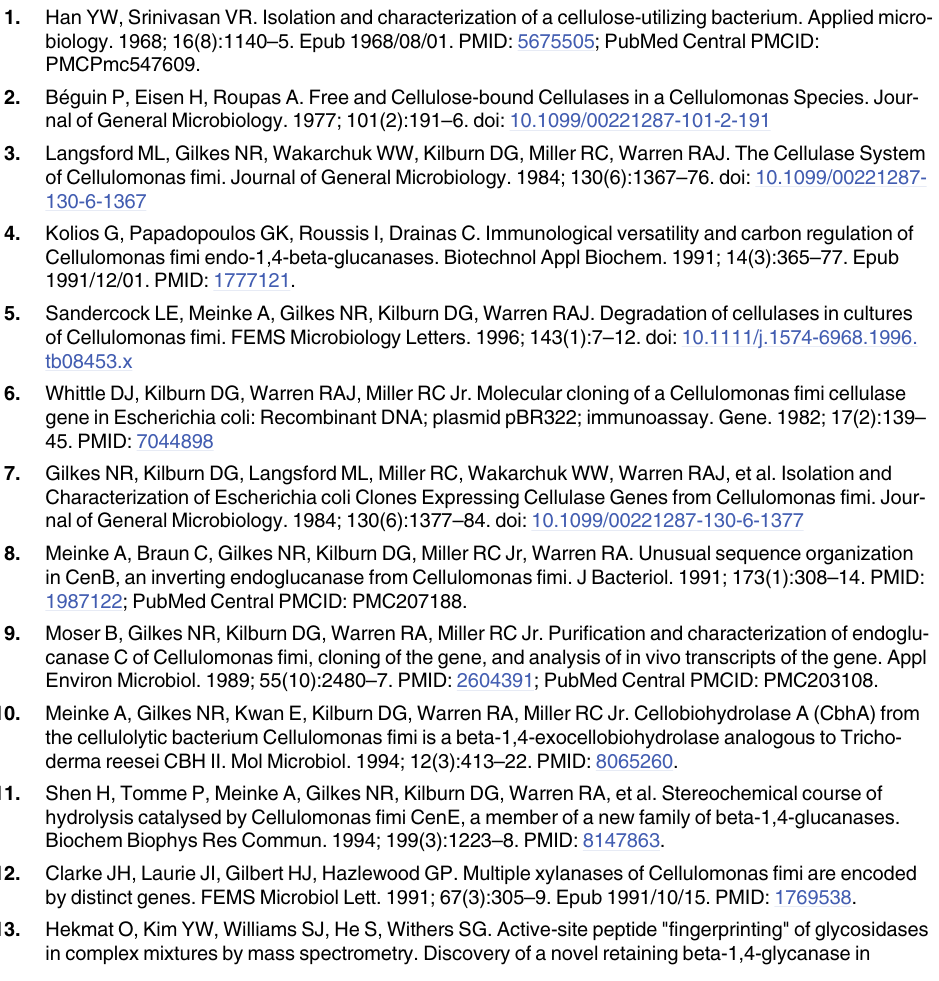
S2 Table. Protein information used to generate the figures. All of the data used to generate protein information figures is in the spreadsheet. The sheets contain data for the individual fig- ures shown in the paper and in the supplemental